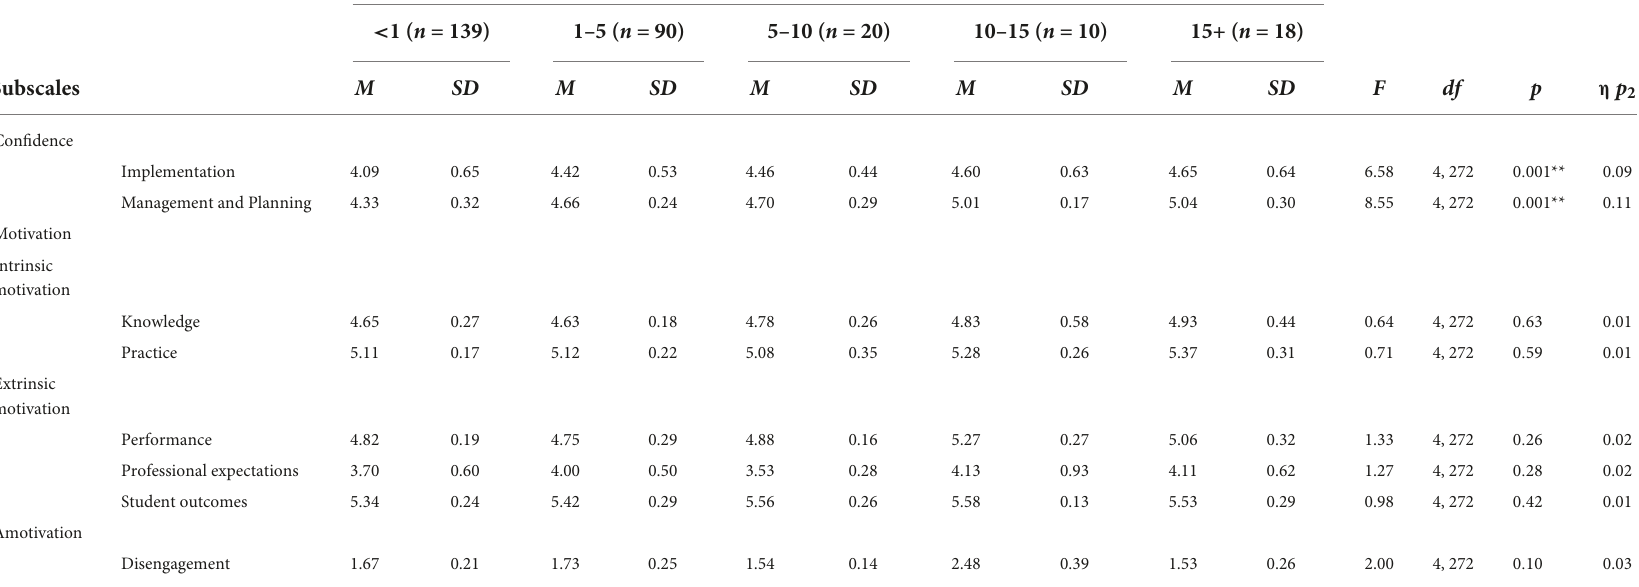
TABLE 7 Descriptive statistics and ANOVA results for confidence and motivation by hours of physical education taught on teaching